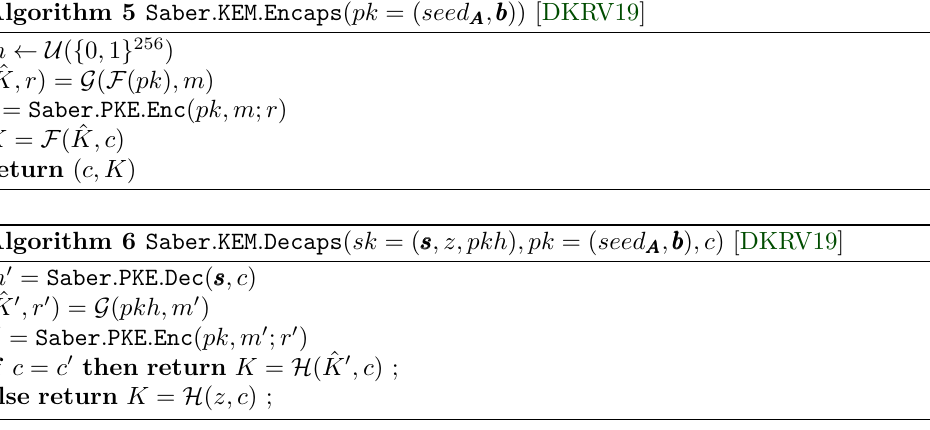
Algorithm 5 Saber . KEM . Encaps ( pk = ( seed AAA ,bbb )) [DKRV19]